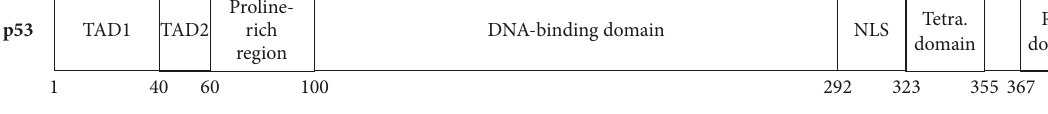
Figure 14: p53 lysine methylation sites (based on PhosphoSite data).